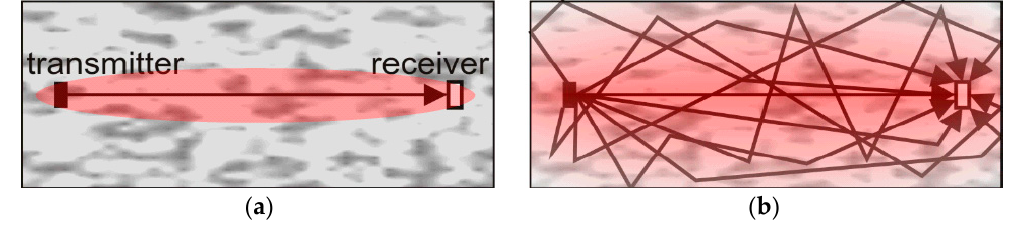
Figure 1. Principle of ultrasonic transmission measurements, propagation paths, and areas of influence (red). ( a ) Direct wave (time of flight); ( b ) multiple scattering